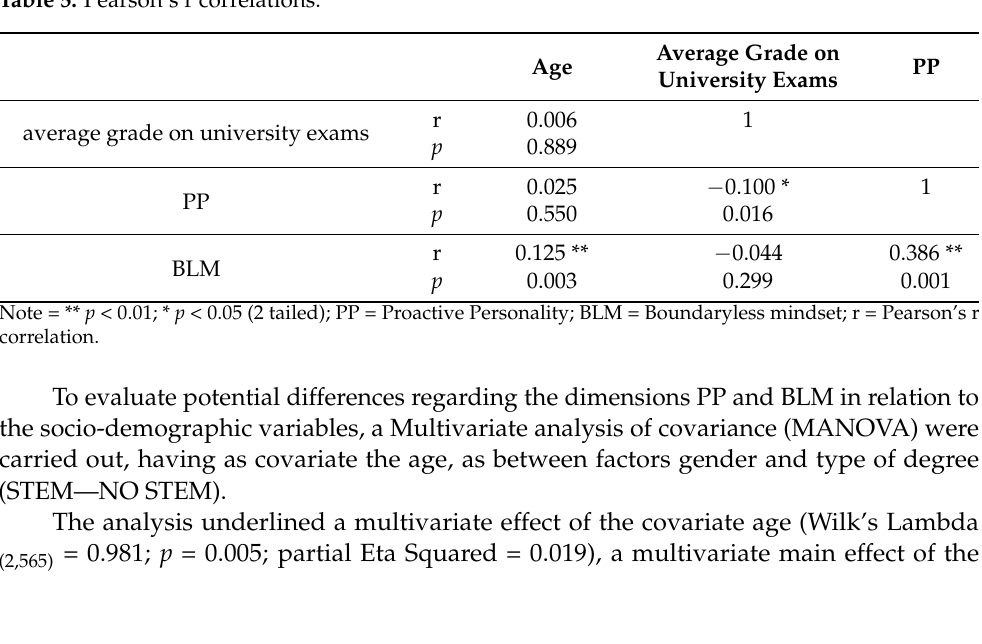
Table 5. Pearson’s r